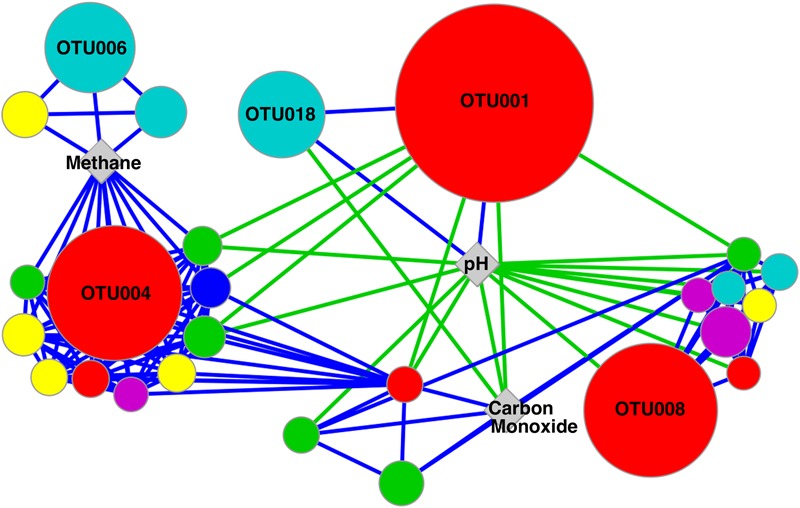
Network diagram of significant correlations between OTUs and environmental variables identified in BEST analysis as accounting for 83% of the variation in community composition (p-value = 0.001). OTU node size is relative to the maximum abundance of the OTU across the samples. Node color represents the taxonomic assignment of the OTU at the Phylum/Class level: β-proteobacteria (red), Firmicutes (blue), α-proteobacteria (green), γ-proteobacteria (teal), Actinobacteria (yellow), and Bacteroidetes (pink). Nodes represent OTUs with a relative abundance >1% of any sample, while OTUs making up >10% of any sample are labeled with OTU IDs. Positive and negative correlations are represented with blue and green lines, respectively.